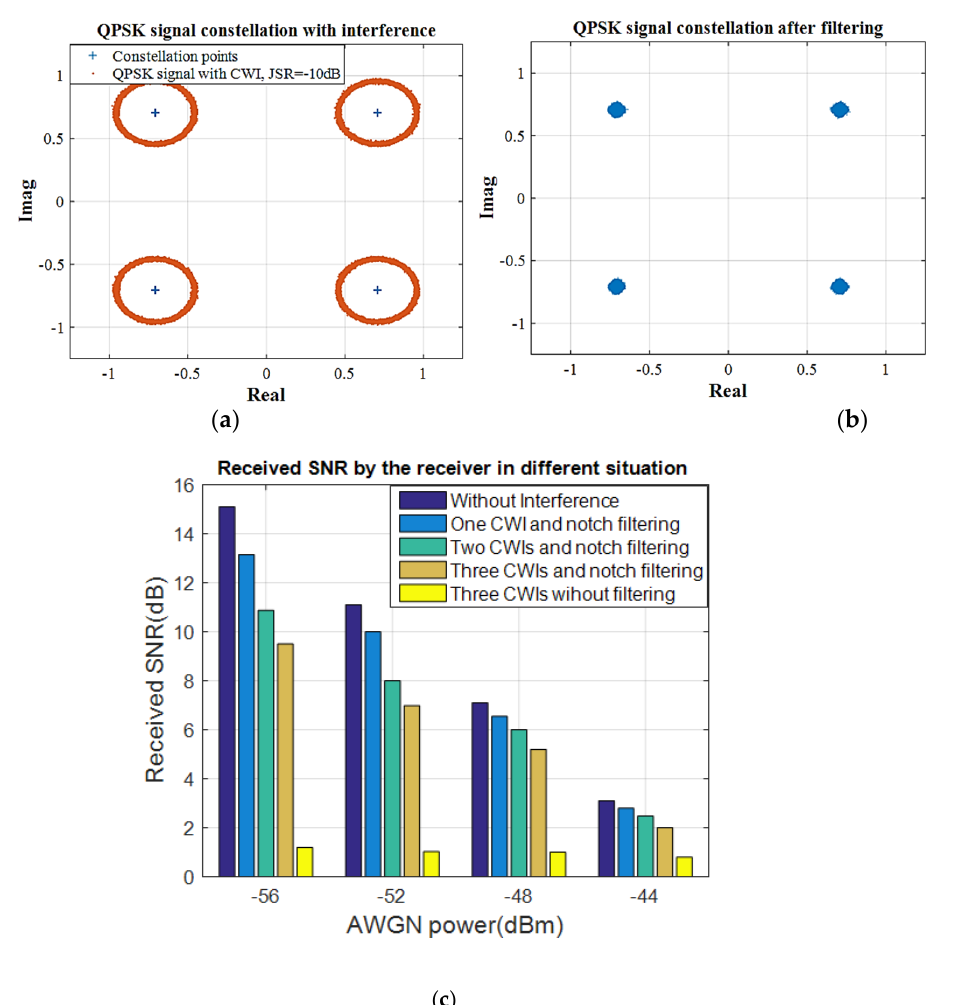
Figure 19. SNR improvement by adaptive filtering; ( a ) Received symbol without filtering; ( b ) Corrected symbols after notch filtering; ( c ) Received SNR by receiver in different situation.